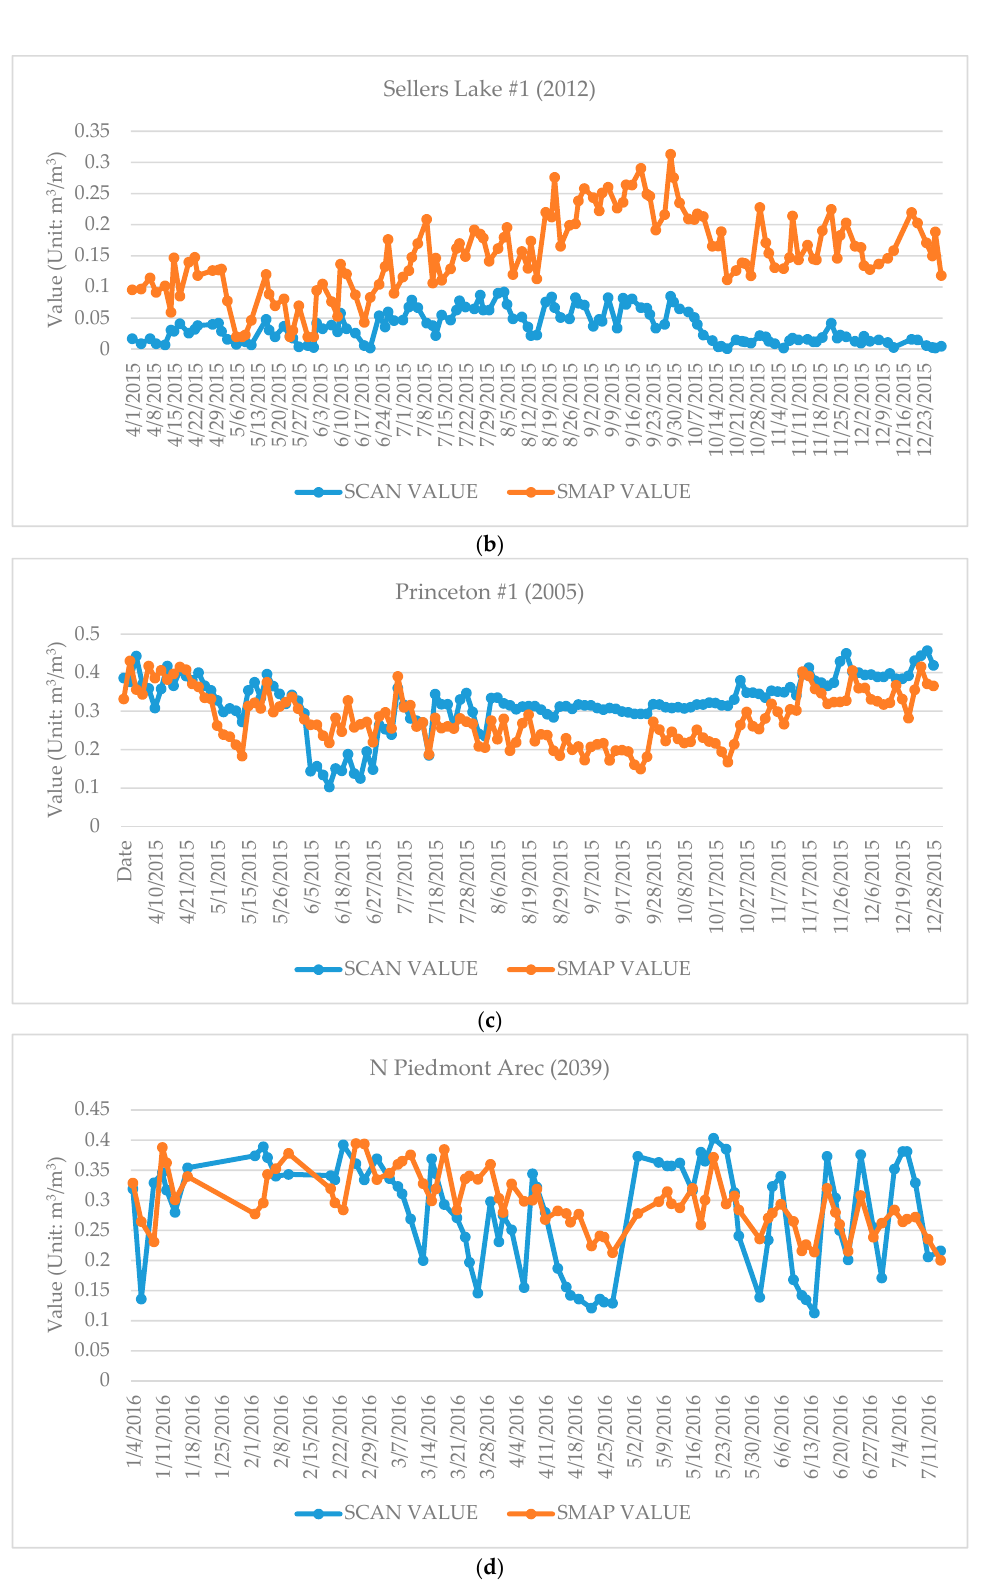
Figure 5. SMAP and SCAN time plot comparison to identify the anomaly: ( a ) Uapb-Earle station in Arkansas (2085); ( b ) Sellers Lake #1 station in Florida (2012); ( c ) Princeton #1 station in Kentucky (2005); and ( d ) N Piedmont Arec station in Virginia